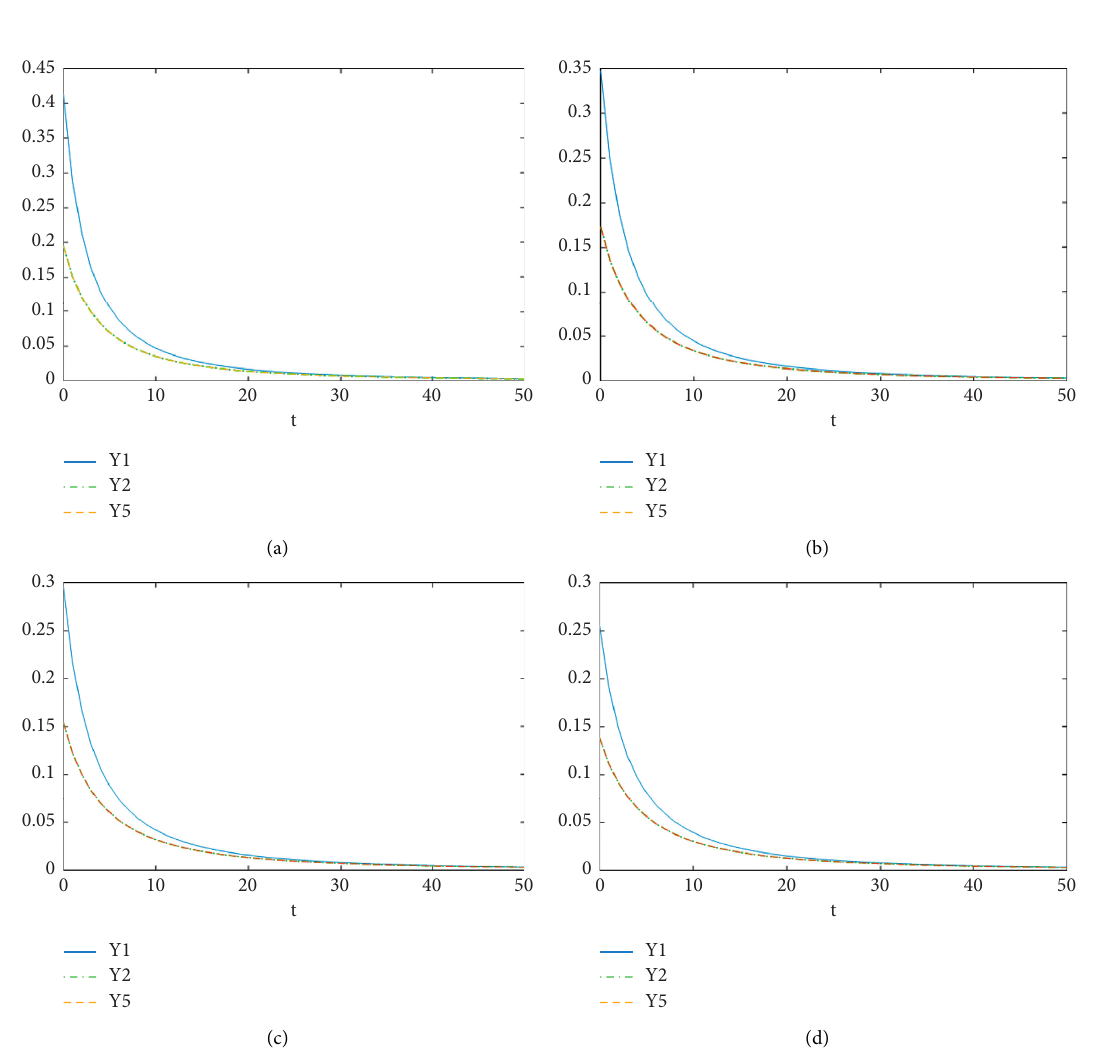
Figure 3: Balanced carbon emissions before and after the integration of Situation I and Situation II ( s β � 0 . 4. (c) β � 0 . 6. (d) β � 0 .